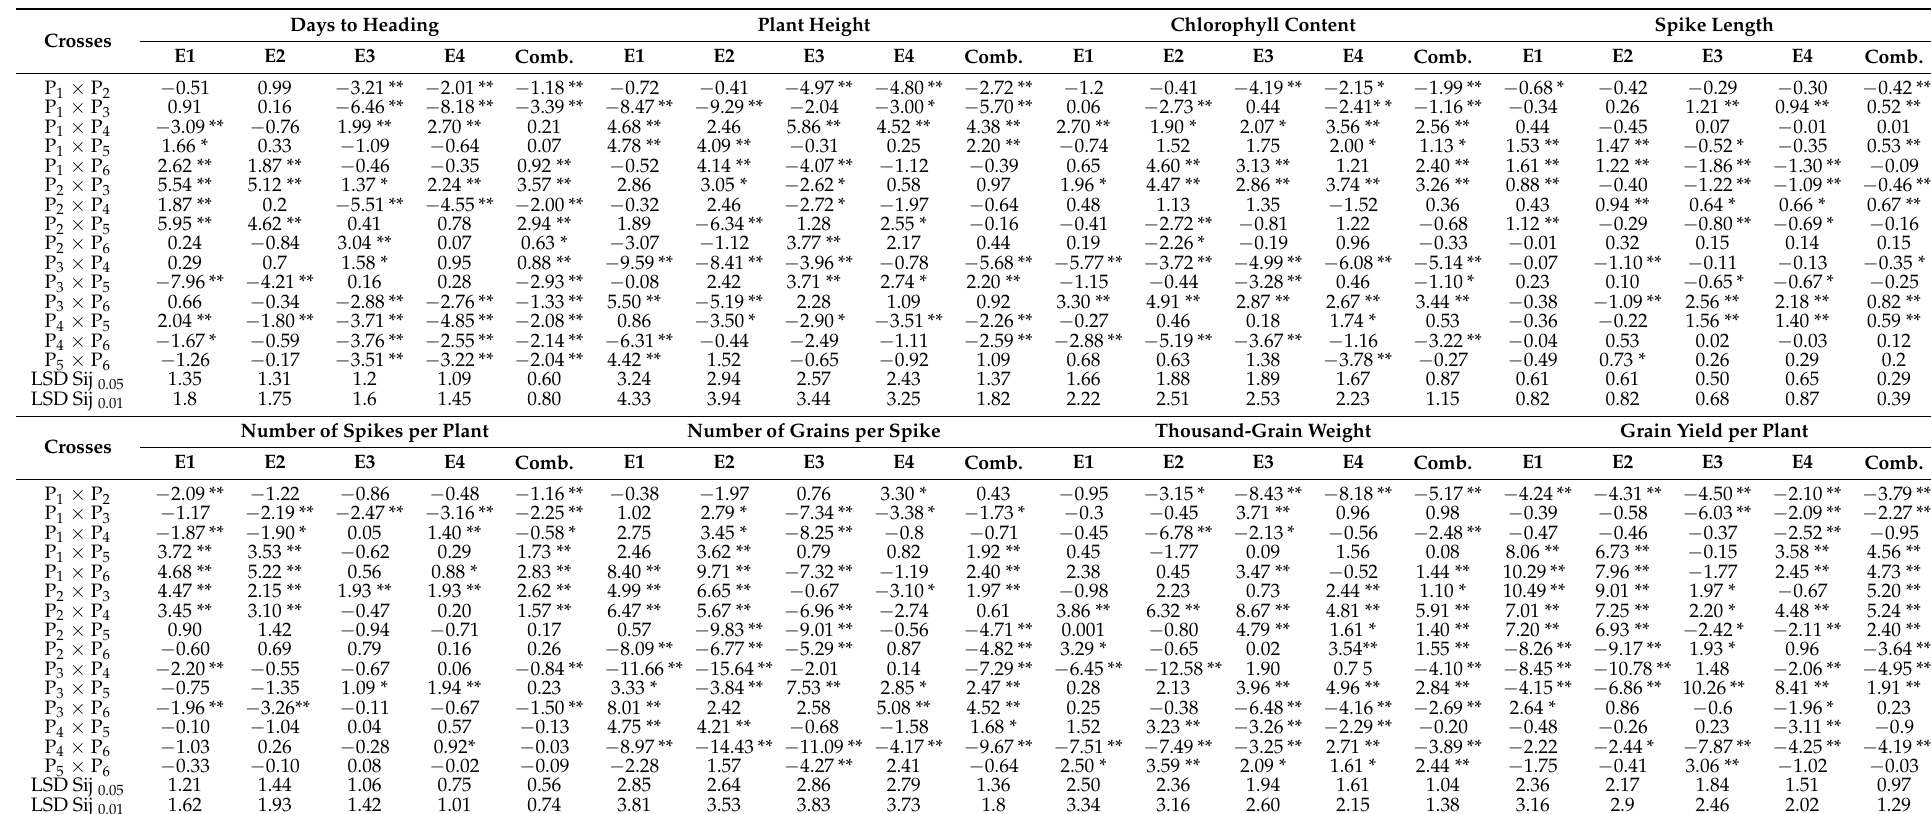
Table 3. Specific combining ability effects (SCA) of 15 F 1 hybrids for all studied traits under tested environments.